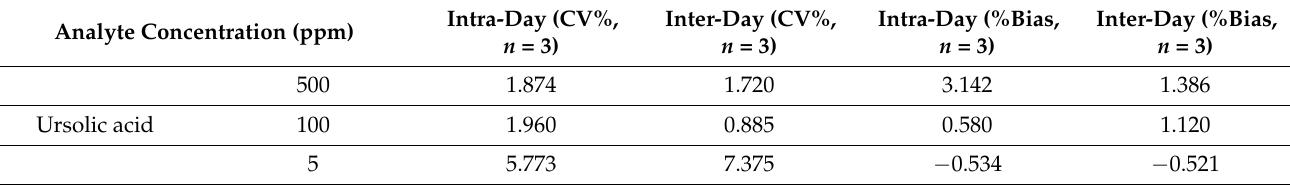
Table 5. Intra-day and inter-day precision and accuracy of